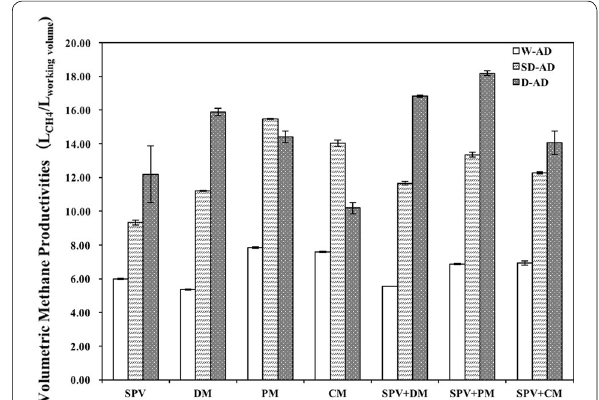
Fig. 3 Comparison of volumetric methane productivities from dif- ferent mixtures of SPV and animal manure under W-AD, SD-AD and D-AD conditions